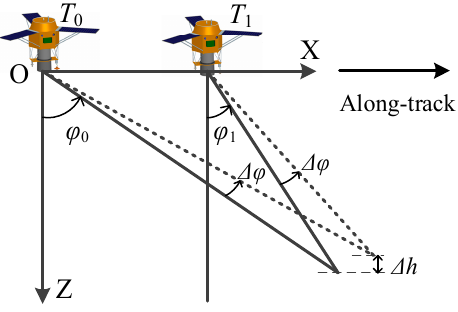
Figure 3. Same-side elevation intersection error.